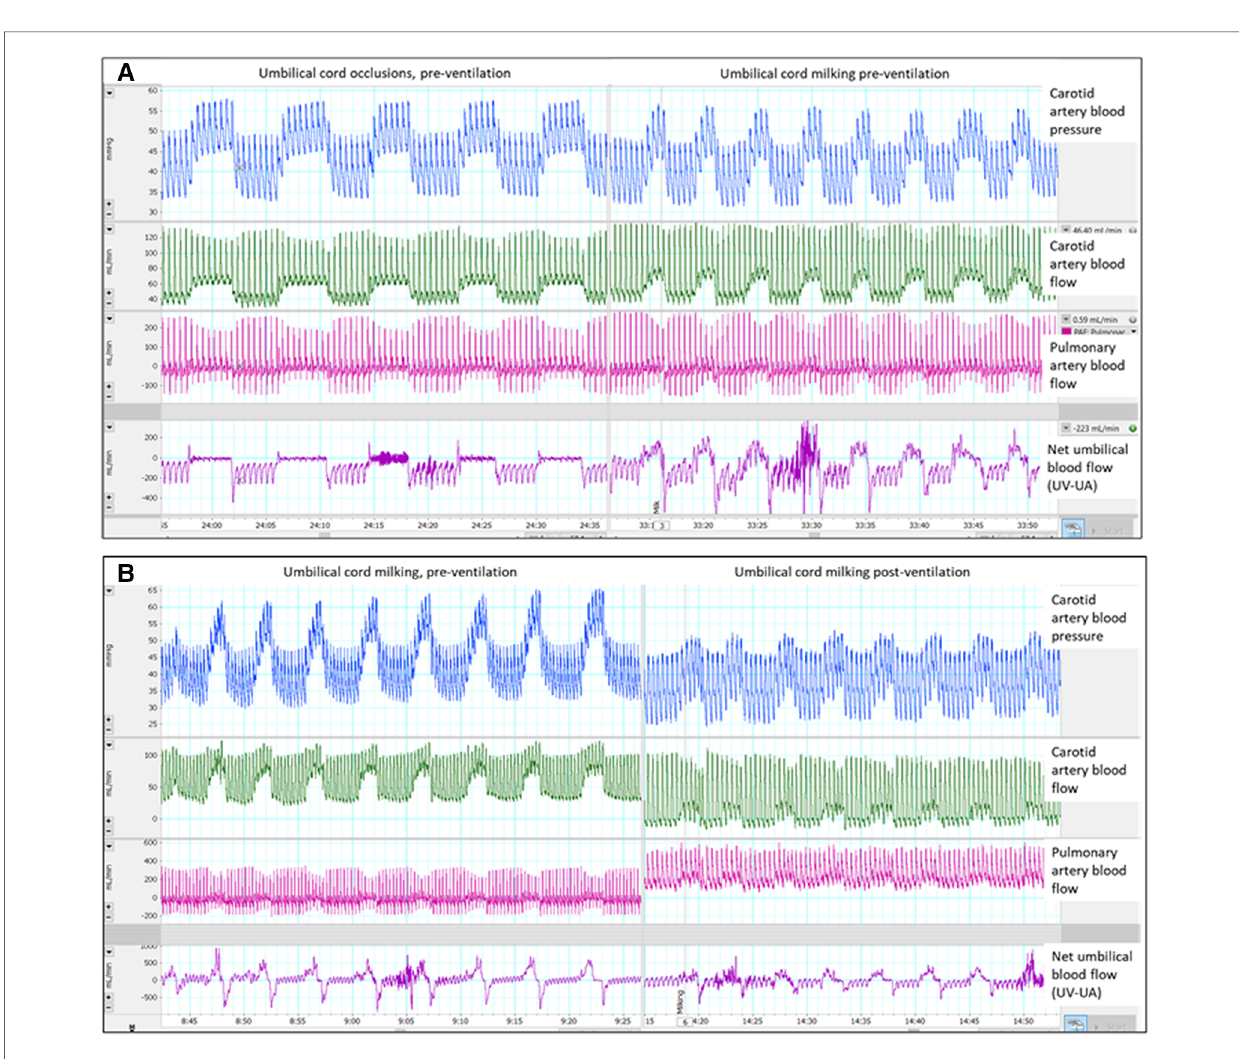
FIGURE 1 Single animal example of umbilical cord milking (UCM) and occlusions pre-ventilation and post-ventilation: Single animal example: ( A ) occlusions vs. umbilical cord milking pre-ventilation and ( B ) umbilical cord milking pre-ventilation vs. post-ventilation, UV=umbilical venous fl ow, UA=umbilical arterial fl